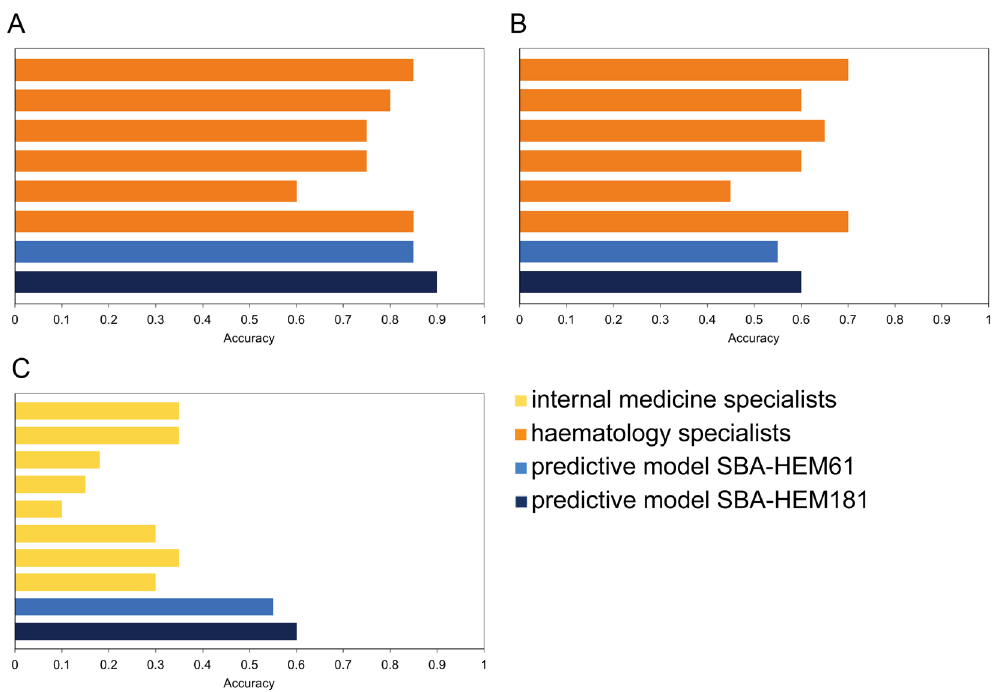
Figure 9. Comparison of the accuracy of internal medicine specialists with both predictive models ( A ) accuracy of the six haematology specialists compared to both predictive models when considering the five most likely predicted diseases; ( B ) accuracy of the six haematology specialists compared to both predictive models when considering only the most likely predicted disease; ( C ) accuracy of the eight non-haematology internal medicine specialists compared to both predictive models when considering the most likely predicted